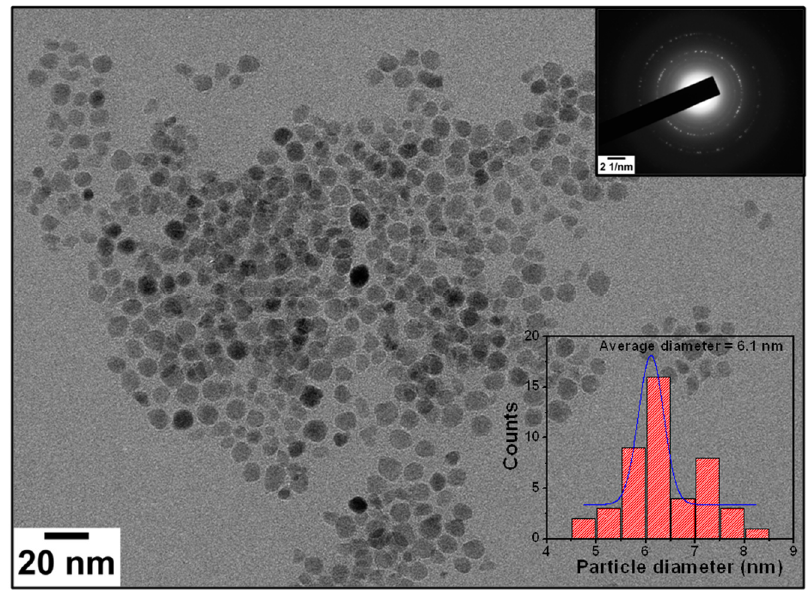
Figure 3. TEM image of silver nanoparticles. The upper inset shows the corresponding SAED pattern, and the lower inset shows the particle size distribution plot.